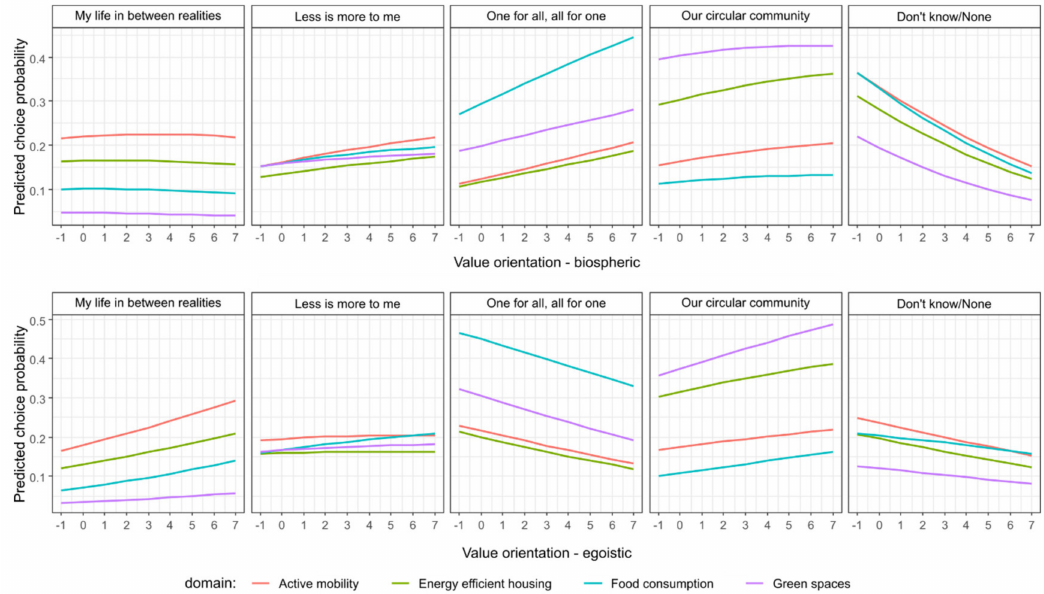
Figure 4. Predicted probabilities of scenario choices by biospheric and egoistic value orientation for domains of living (Predicted probabilities from the multinomial logit model presented in Table 2, fixed at country = CZ, household income = “2nd tercile”, municipality size = “town”, age = “35–49 years”, Education = “upper secondary”, gender = “Female”, Chronic disease = ”none”, means for altruistic, hedonic, and security values, and (alternatively) biospheric or egoistic value